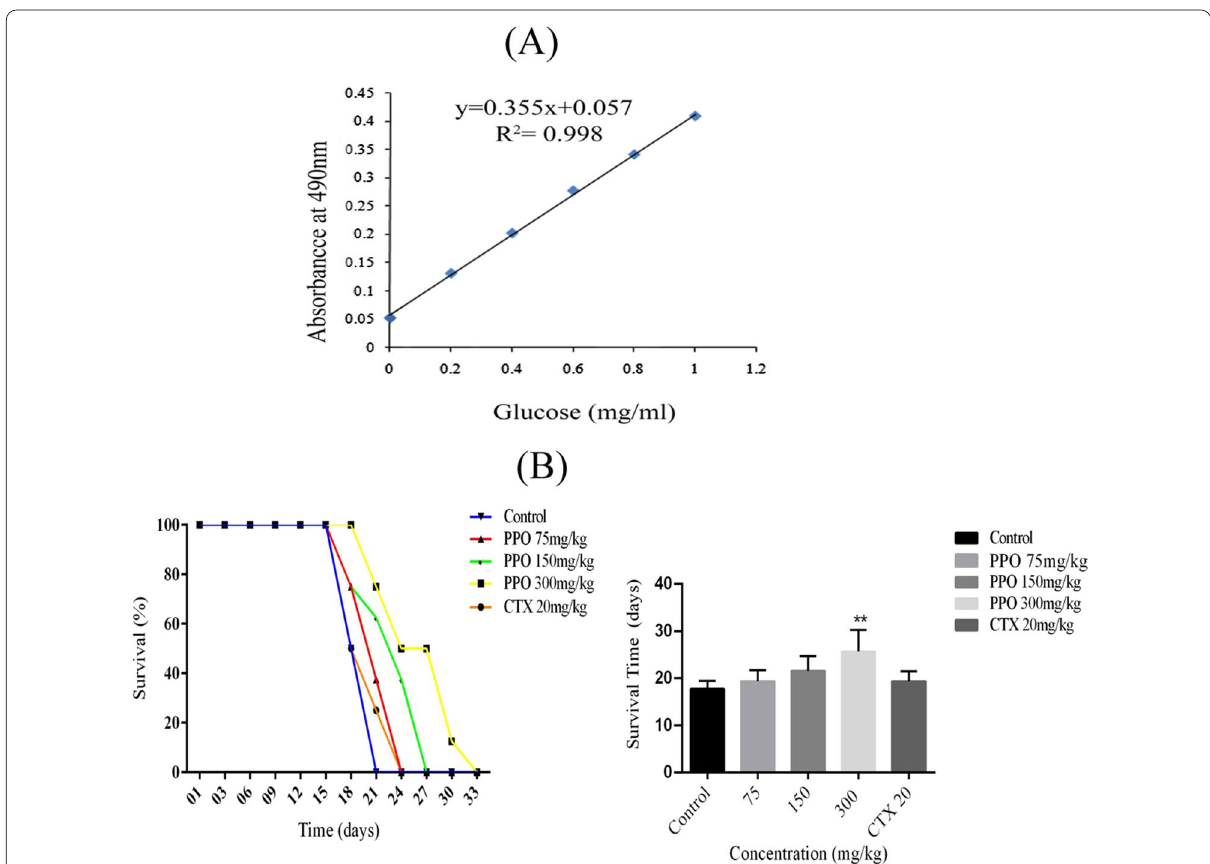
Fig. 1 Polysaccharide extracted from Pleurotus ostreatus A Standard curve used to quantitate total carbohydrate component in extract B Murine hepatocarcinoma H22 malignant ascites models were established to observe survival time of mice models after treating with polysaccharide and results shows dose-dependent increase in survival period *p < 0.05, **p < 0.01, ***p < 0.001. (n *CTX